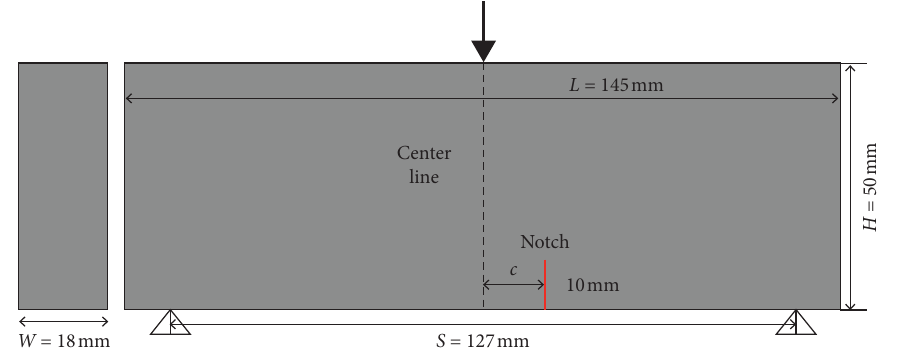
Figure 4: Geometry of the worked example.